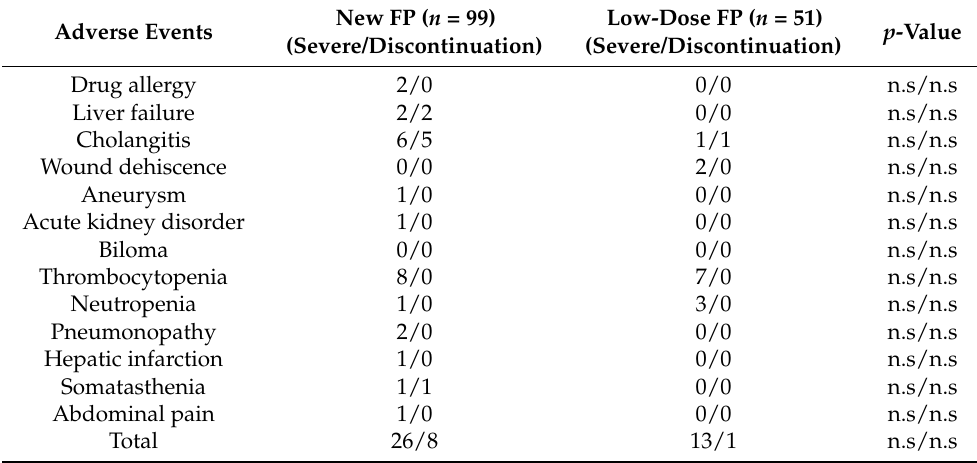
Table 2. Incidence rate and profiles of adverse events in the New FP and Low-dose FP groups. Adverse